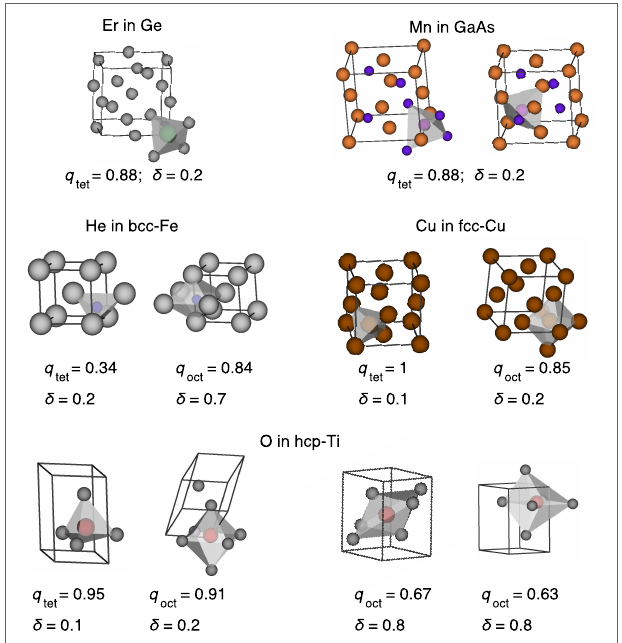
FIGURE 10 | Interstitials found in five different materials with our tool InFiT (here: conventional unit cell for clarity).